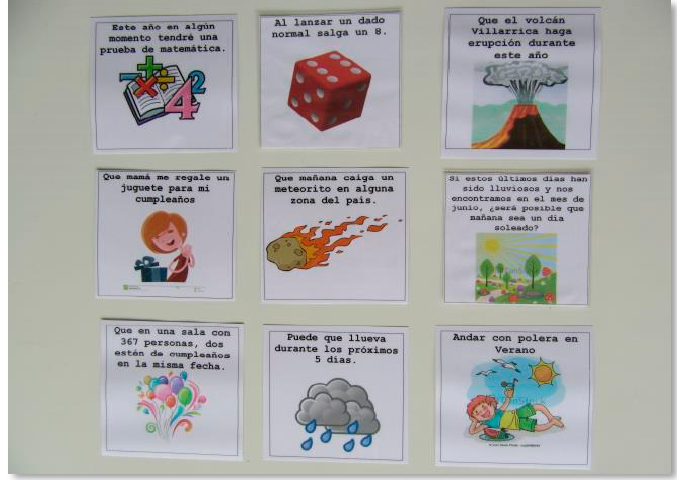
Figure 5. Image capture for 5th grade class.